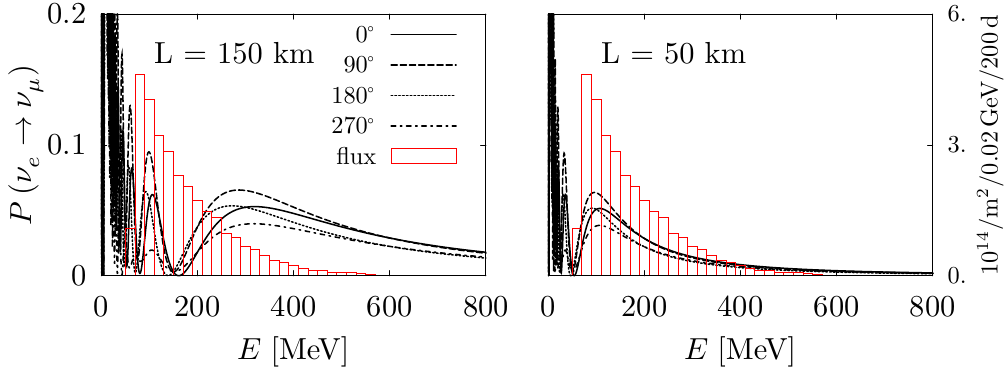
Figure 1. The transition probability for the (cid:23) e ! (cid:23) (cid:22) channel, presented for the values (cid:14) CP = 0 (cid:14) , 90 (cid:14) , 180 (cid:14) and 270 (cid:14) . The probabilities are shown as functions of the neutrino energy E = 0. . . 800 MeV. In the left panel, the probabilities are shown for the experimental con(cid:12)gurtion where the baseline length L is optimized for the second oscillation maximum ( L = 150 km). In the right panel, the probabilities are correspondingly shown for the (cid:12)rst oscillation maximum ( L = 50 km). For convenience, the simulated electron neutrino (cid:13)uxes for MOMENT are shown with the red boxes. The (cid:13)uxes are given in units of 10 14 /m 2 / 0.02 GeV/ 200